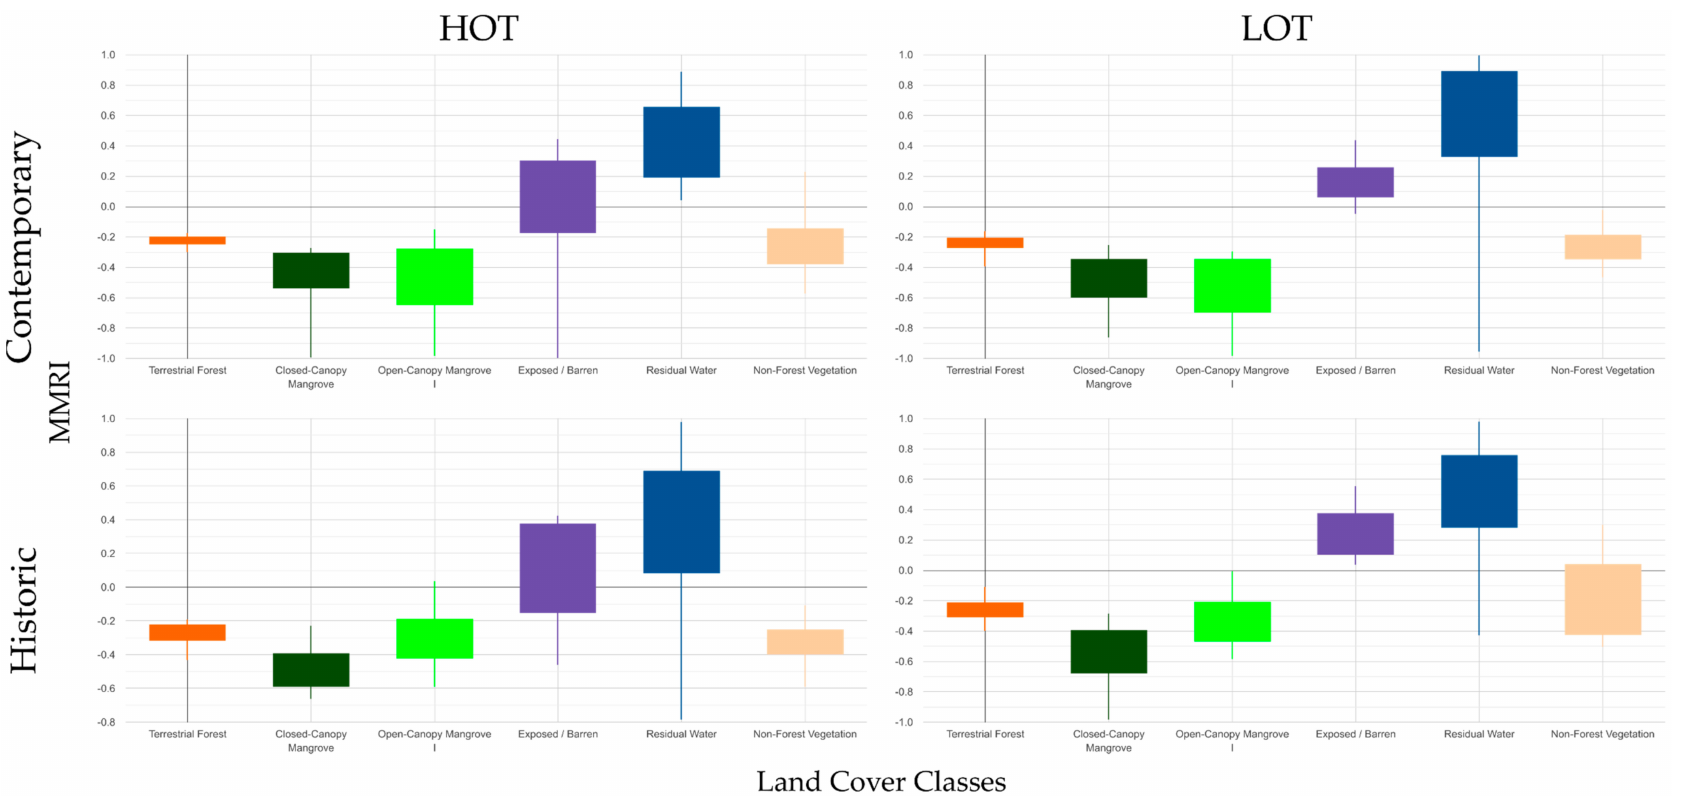
Figure 8. Example of index-specific overview of spectral values by land-cover class as represented by CRAs. MMRI is shown for each the historic and contemporary HOT and LOT datasets. The bar-whisker plots represent the min, max, and interquartile range (IQR) for each